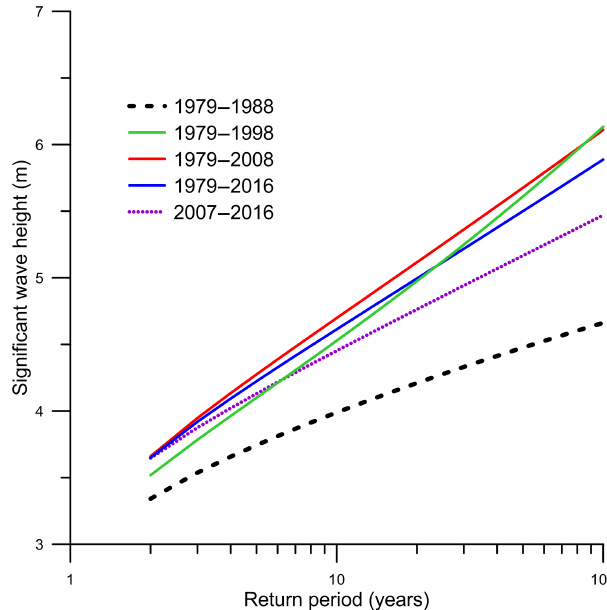
Figure 10. Return levels of significant wave heights for different return periods based on ERA-Interim shallow water data in different block years by the GEV model using annual maxima